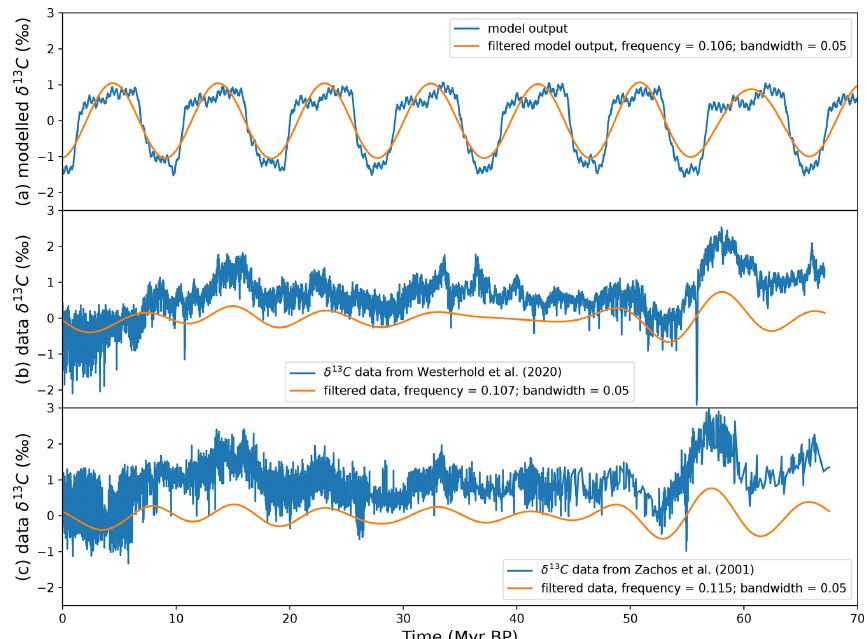
Figure 11. Comparison of (a) the modelled δ 13 C and (b) deep-sea record δ 13 C (data are from Westerhold, 2020) in blue and filtered (frequency = 0.107; bandwidth = 0.05) in orange. The modelled δ 13 C shown was taken among the model outputs that produce ∼ 9Myr cyclicities. Table 1. Value of the different parameter sets displayed in Fig. 10. Set 1 Set